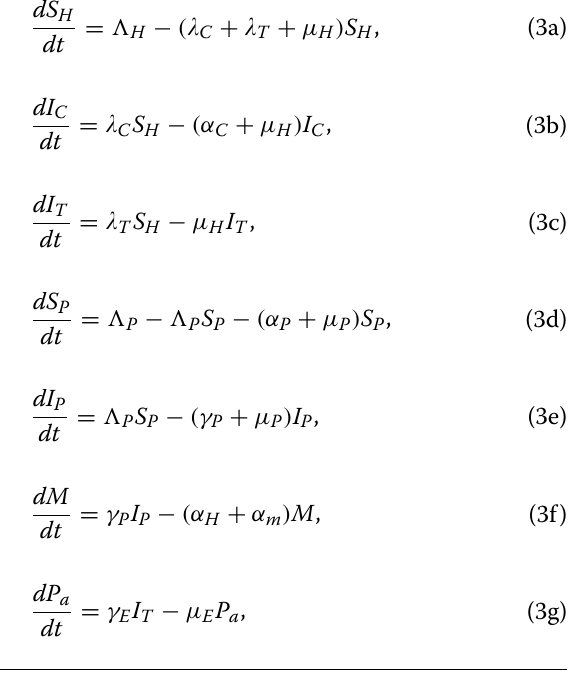
Table 1 described model parameters and interactions of variables are described in Fig. 1. Using parameter values in Table 1 and state variables in Fig. 1, the model system for Taenia solium taeniasis and cysticercosis is given